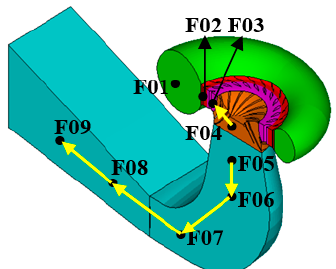
Figure 13. Presentation of pressure pulsation transmission path based on the original fluid pressure